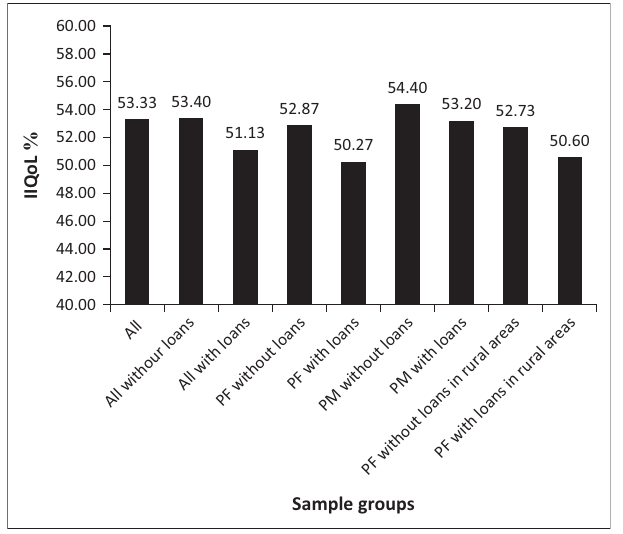
FIGURE 1: Income-independent quality of life of various